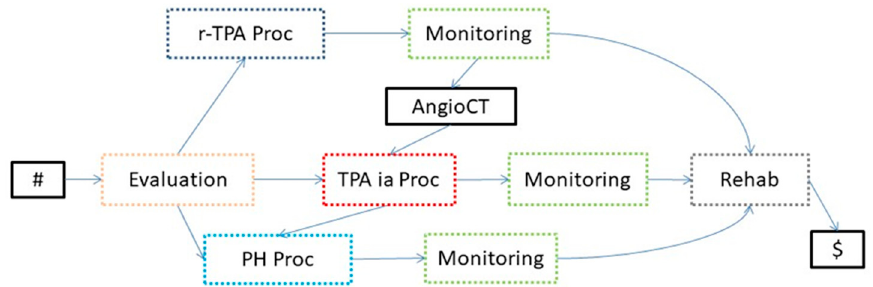
Figure 7. Process model abstracted at level 2 through the fully automatic algorithm.